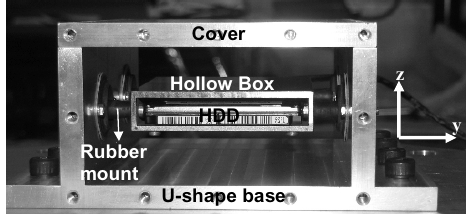
Fig. 11. Vibration isolation system I.